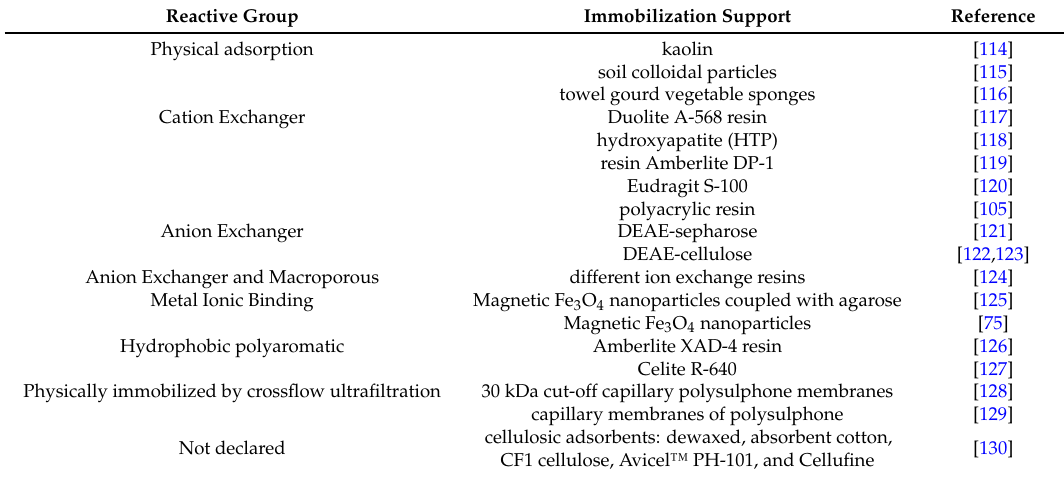
Table 2. β -glucosidases immobilization by